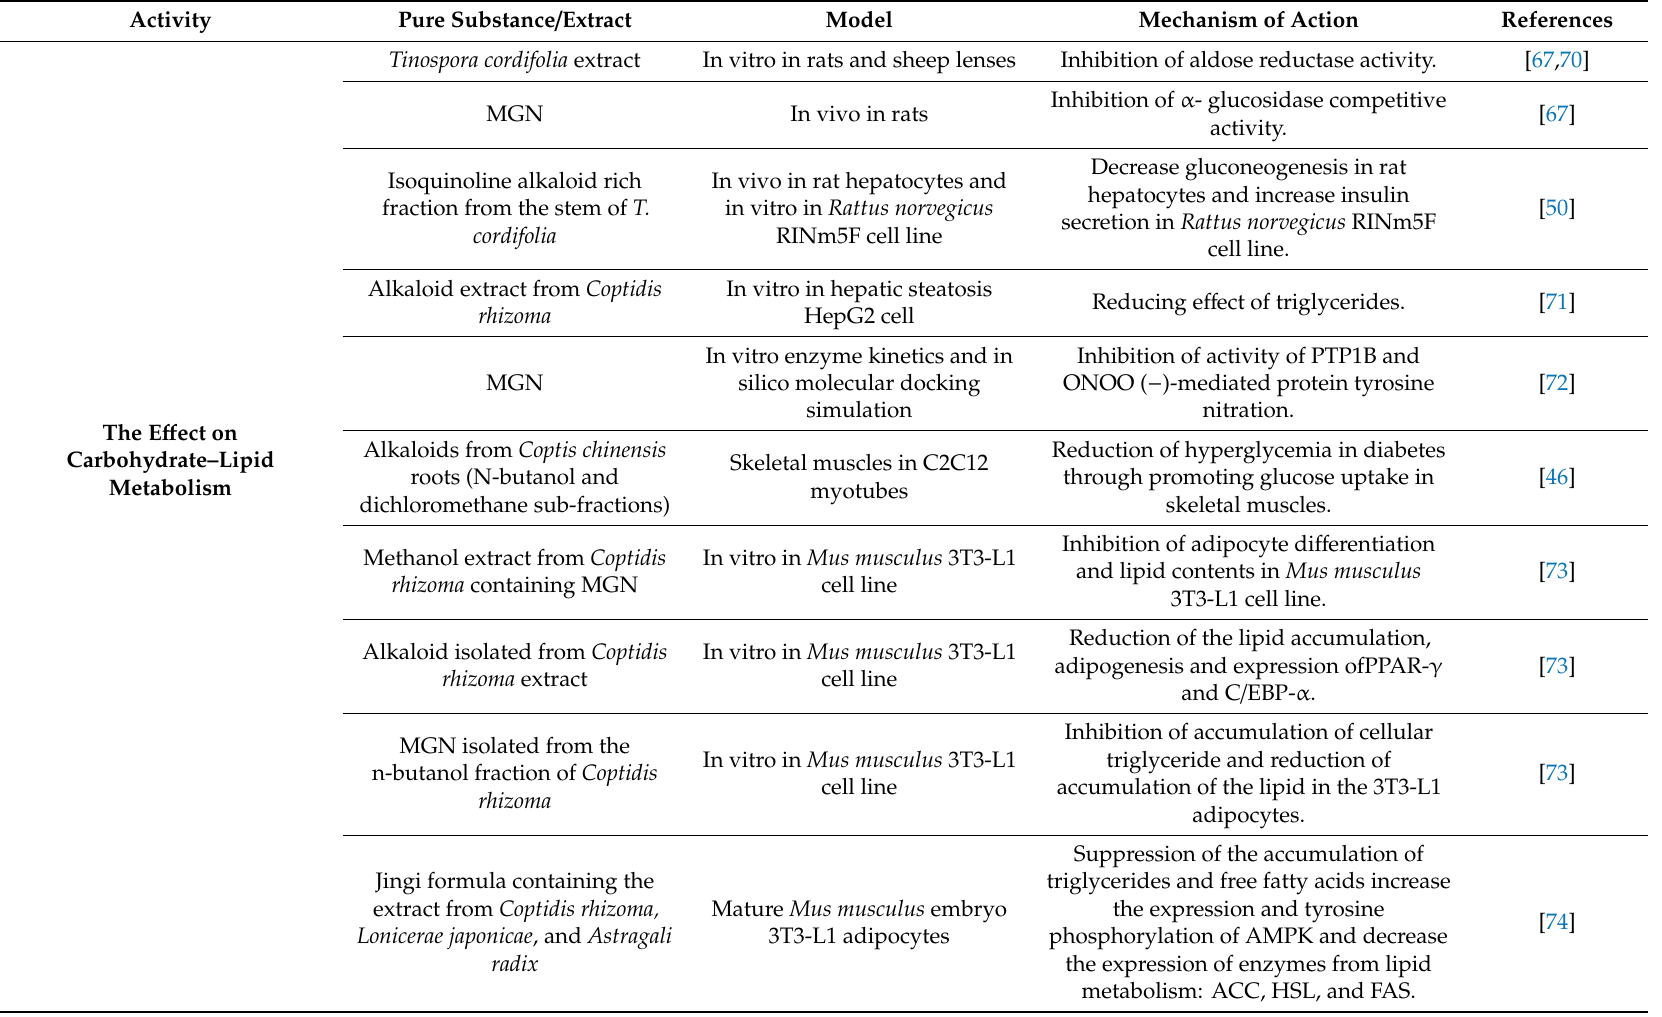
Table 2. Biological activities of magnoflorine (MGN) and extracts containing